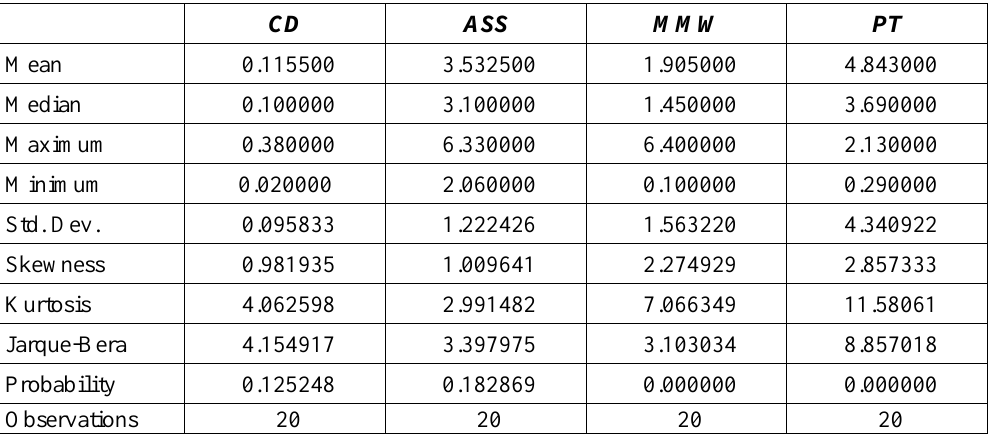
Table 2. Descriptive Statistics (authors’ computation,